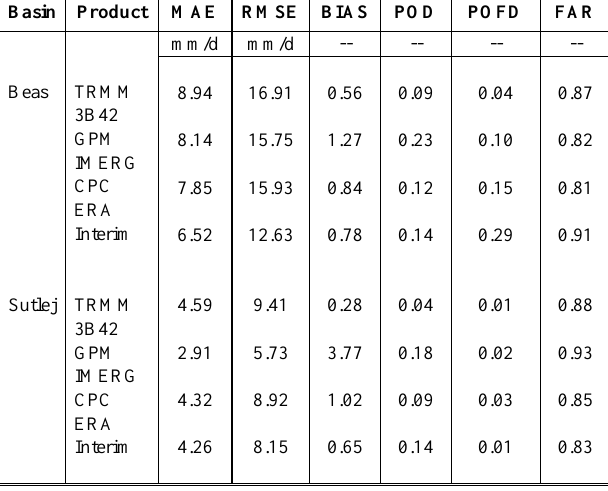
Table 2: Summary Statistics of Estimated